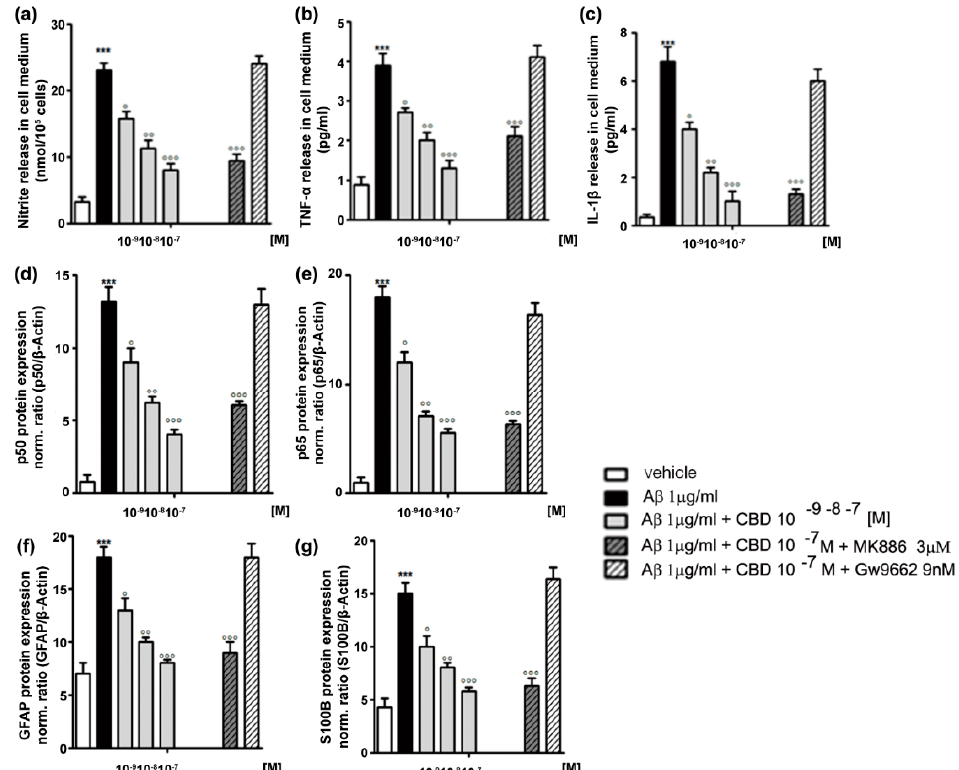
Figure 5. CBD actions on astrocytes. ( a – c ) Effects of CBD on the release of inflammatory mediators, ( a ) nitrite, ( b ) TNF- α , and ( c ) IL-1 β by the in vitro cultured astrocytes. A β -challenged astrocytes (1 mg/ml) were treated with CBD (10 − 9 –10 − 7 M) in the presence of PPAR α (MK886, 3 mM) or PPAR γ